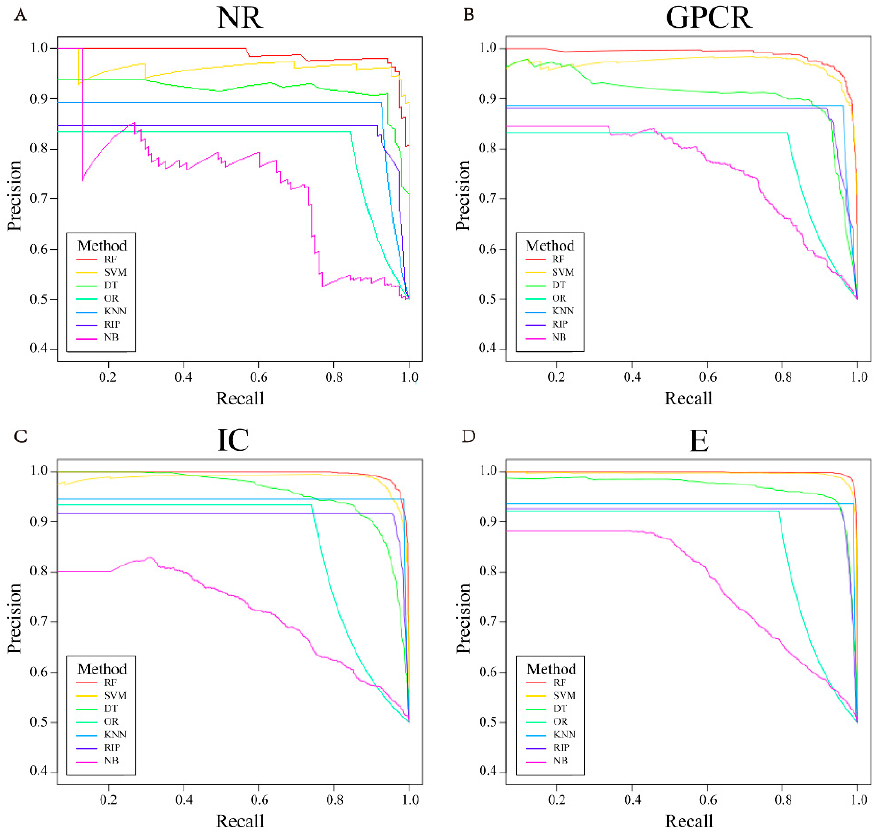
Figure 4. The representative PR curves of different classifiers in 5-fold cross-validation of four datasets, i.e., NR ( A ), GPCR ( B ), IC ( C ), E ( D ).